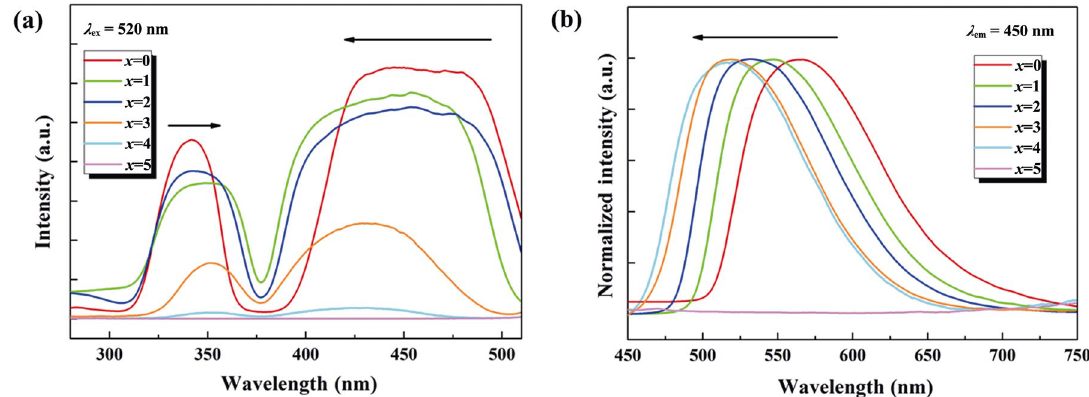
Fig. 7 PLE and PL spectra of Y 3 Al 5– x Ga x O 12 :Ce ( x = 0–5)